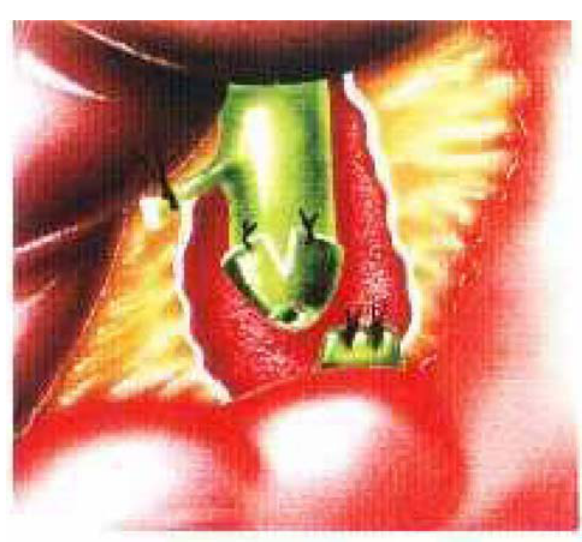
FIGURA 4 - Desenho mostra a sutura da parede posterior colédoco à parede posterior do duodeno.